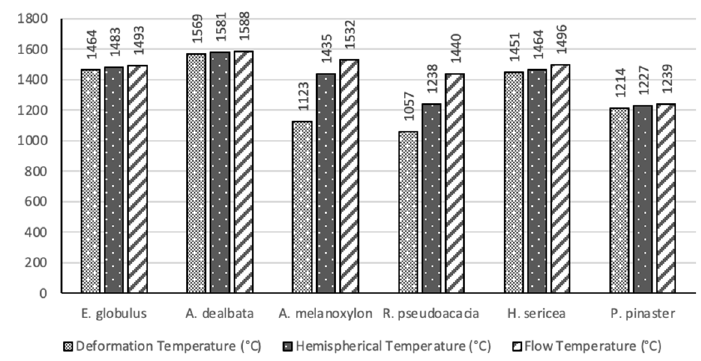
Figure 8. Ash fusibility temperatures.